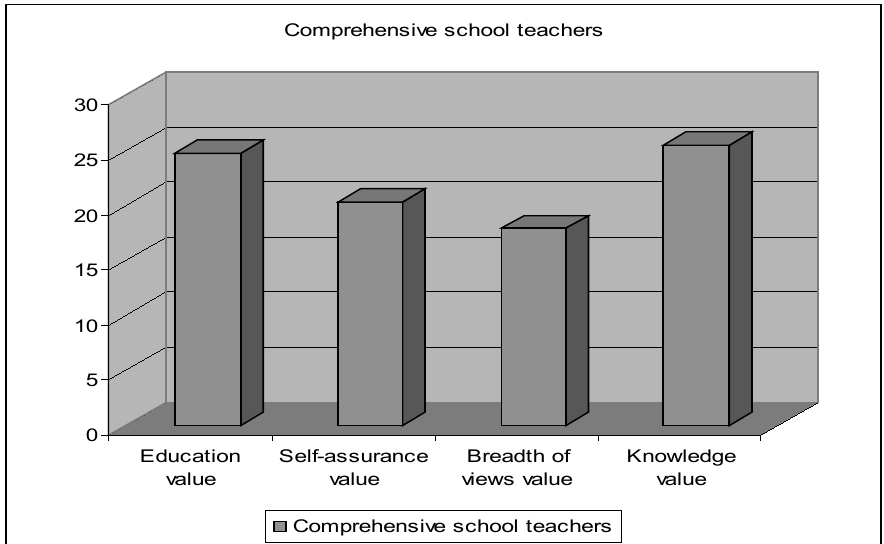
Fig. 1.1. The results of percentage analysis under M. Rokeach „Human values” methods in the group of comprehensive school teachers.